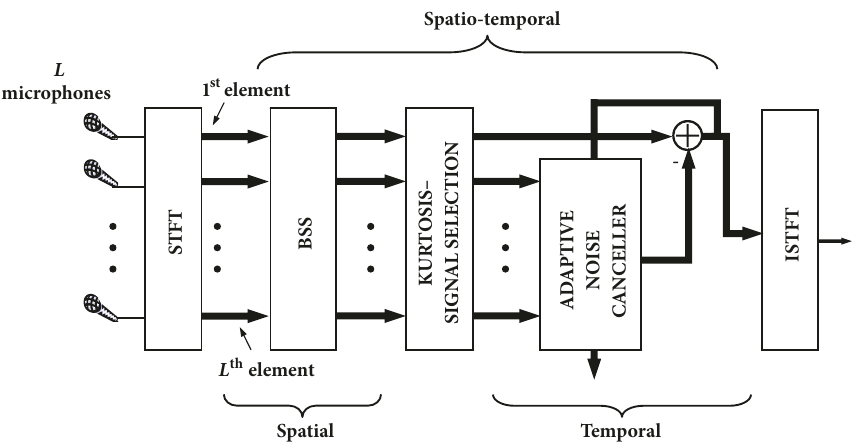
Figure 1: The spatiotemporal processor with 퐿 microphones. The figure shows how the kurtosis unifies the spatial and temporal decorrelators as one spatiotemporal processor. Each bold arrow represents the 푀 frequency